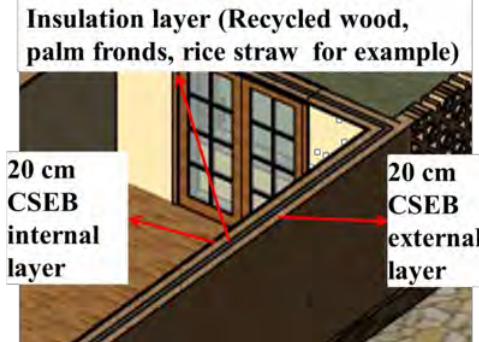
Figure 3. Isometric of the multi-shell wall for the energy efficient envelope of the residential